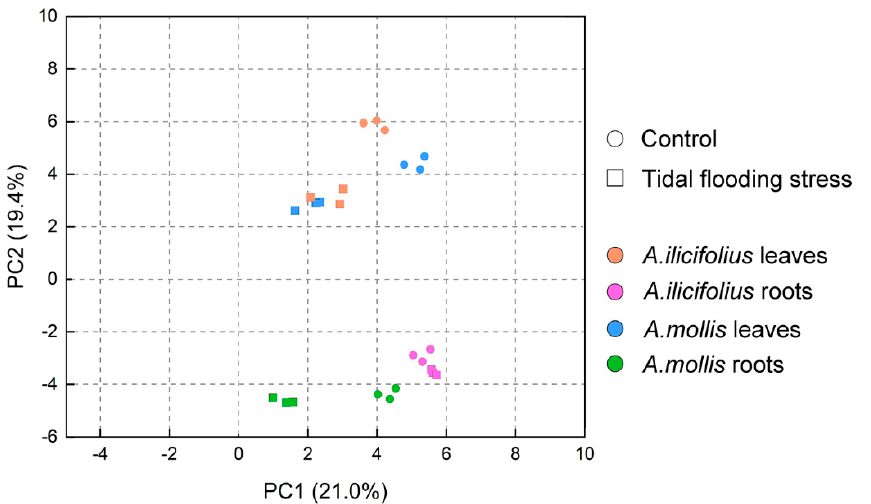
Figure 4. Principal component analysis (PCA) of total proteome data for the tissues of A. ilicifolius and A. mollis . Percentage variance for each principal component is given.